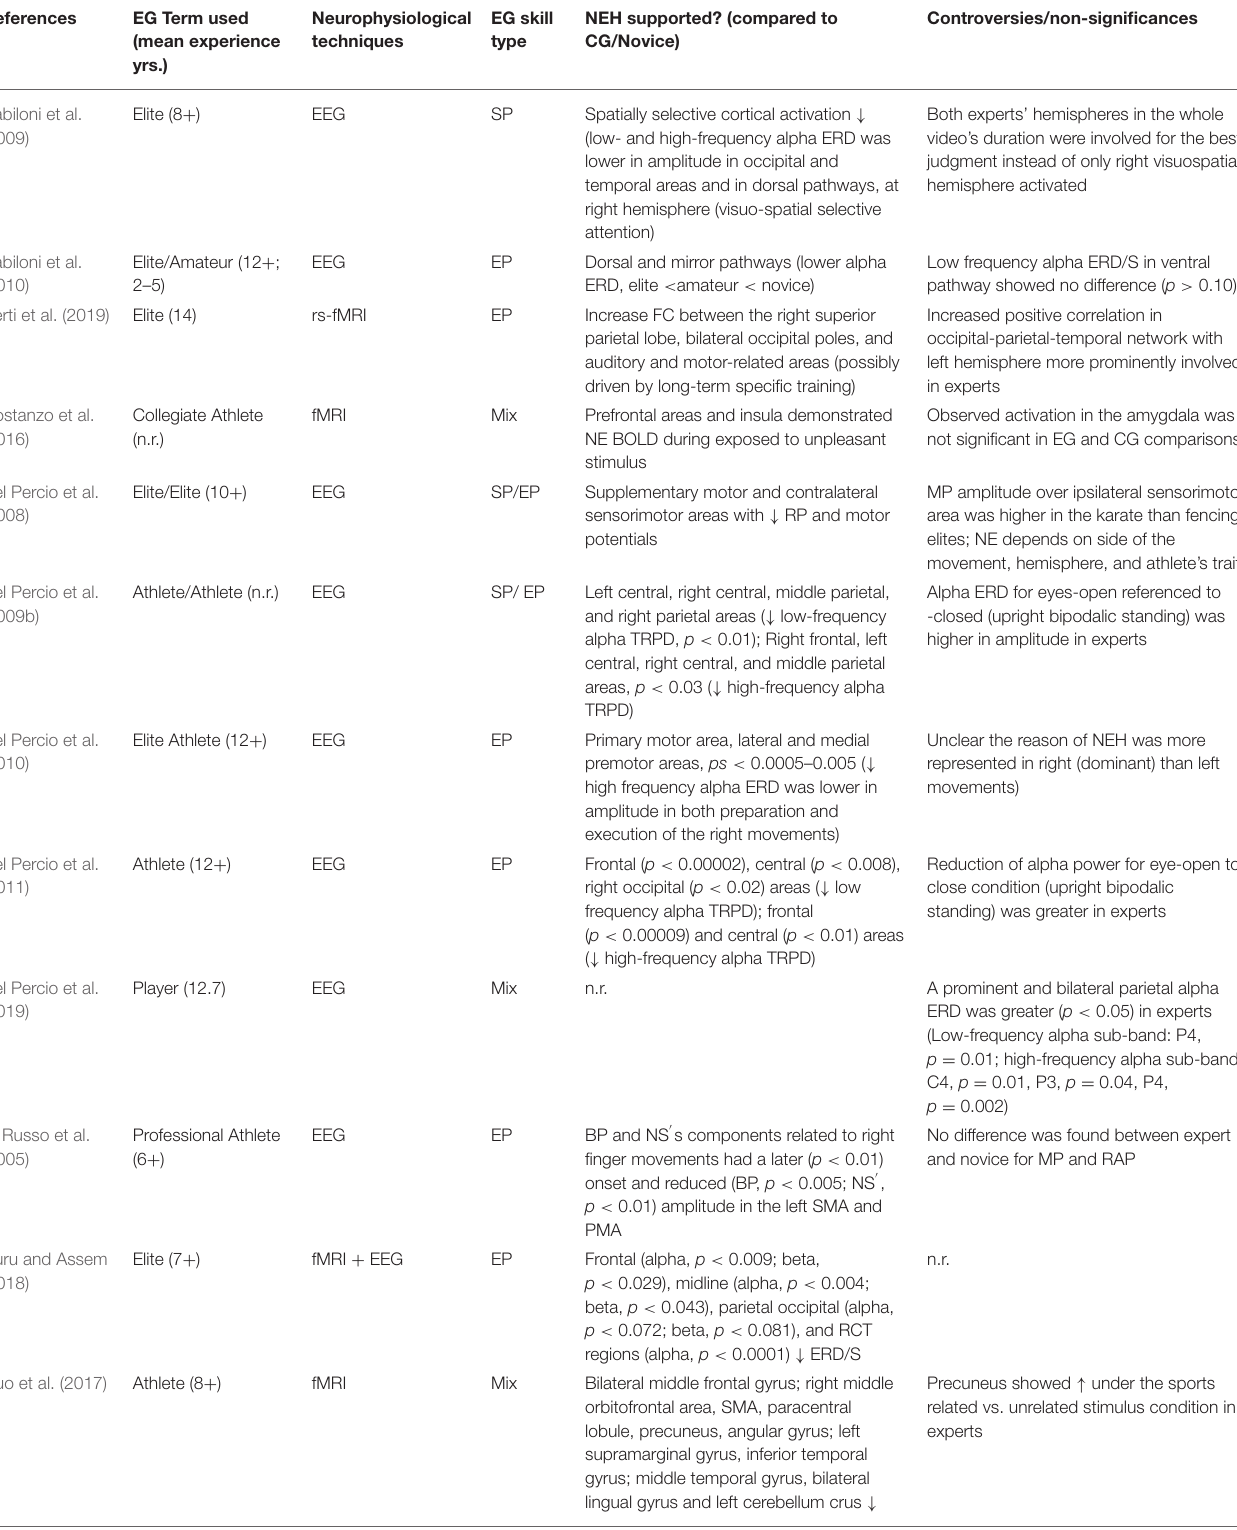
TABLE 3 | Extraction table of the studies examining the neural efficiency hypothesis in experts-novices